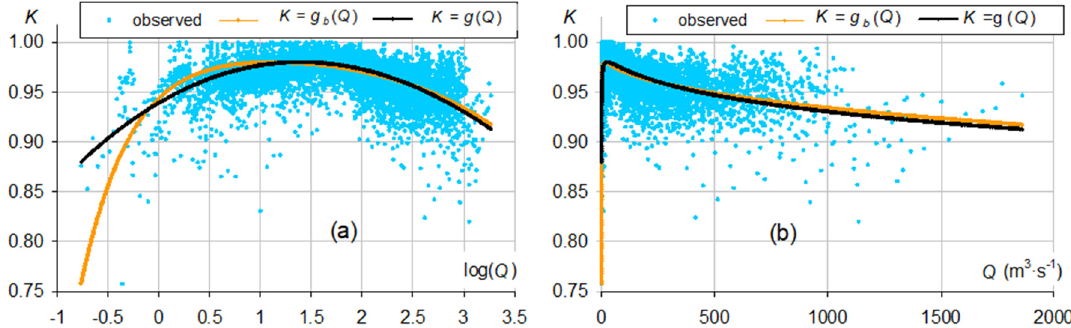
Figure 4. Relationship between discharge Q and K at Daka Saidou on the Bafing (row 8; 10,966 points observed from 5 october 1952 to 20 october 2016; C NSE0 = 0.392 for model 2 with K = g ( Q ); C NSE0 = 0.335 for model 4 with K = gb ( Q )), with abscissa in logarithmic values on the left ( a ) and natural values on the right ( b ).